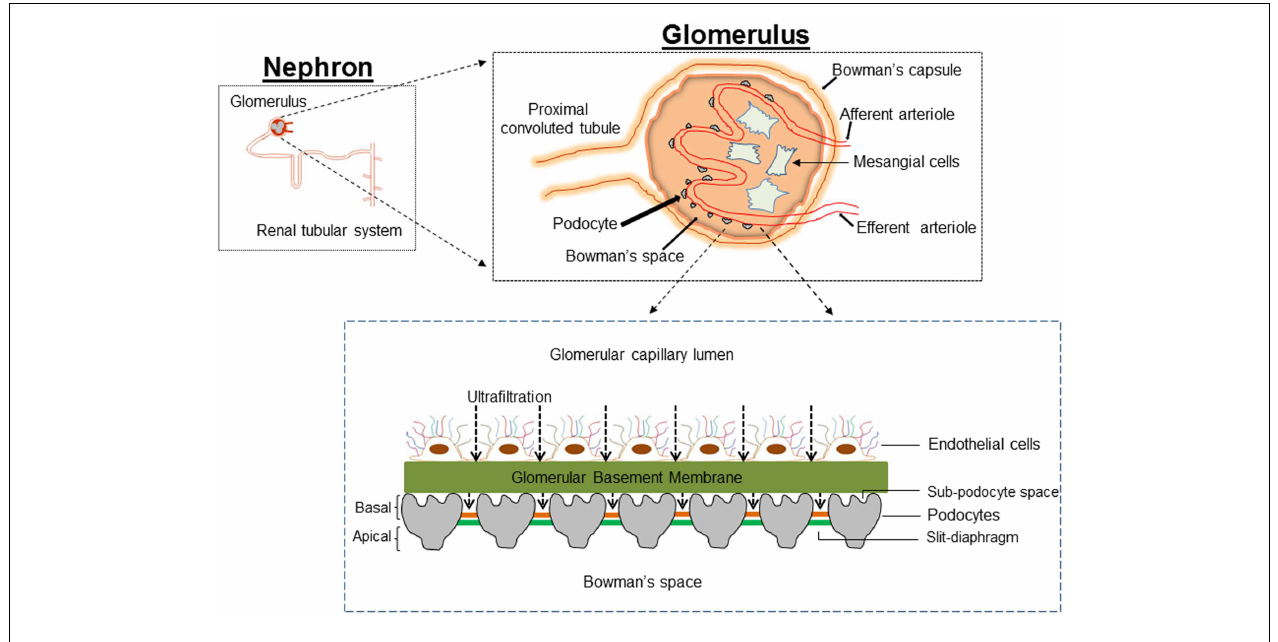
which further ramify into smaller foot processes. Foot processes from neighboring podocytes interdigitate and are connected by a modified adherent junction called slit-diaphragm (SD) that provides intercellular space for the passage of glomerular